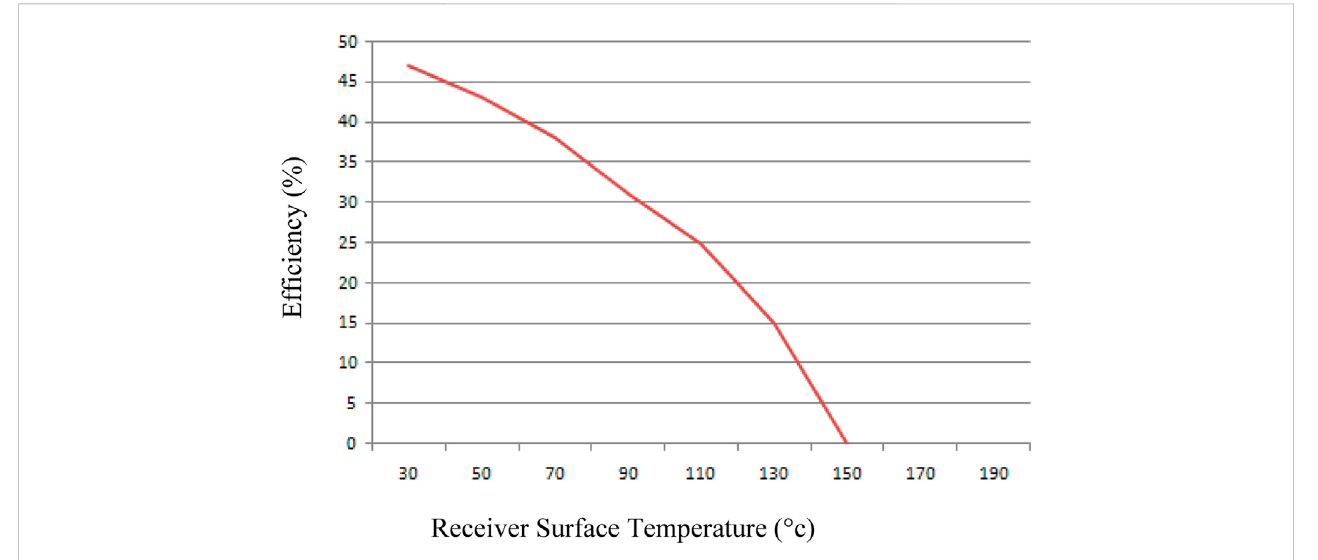
Ef fi ciency vs. the receiver surface temperature for a .038-m receiver